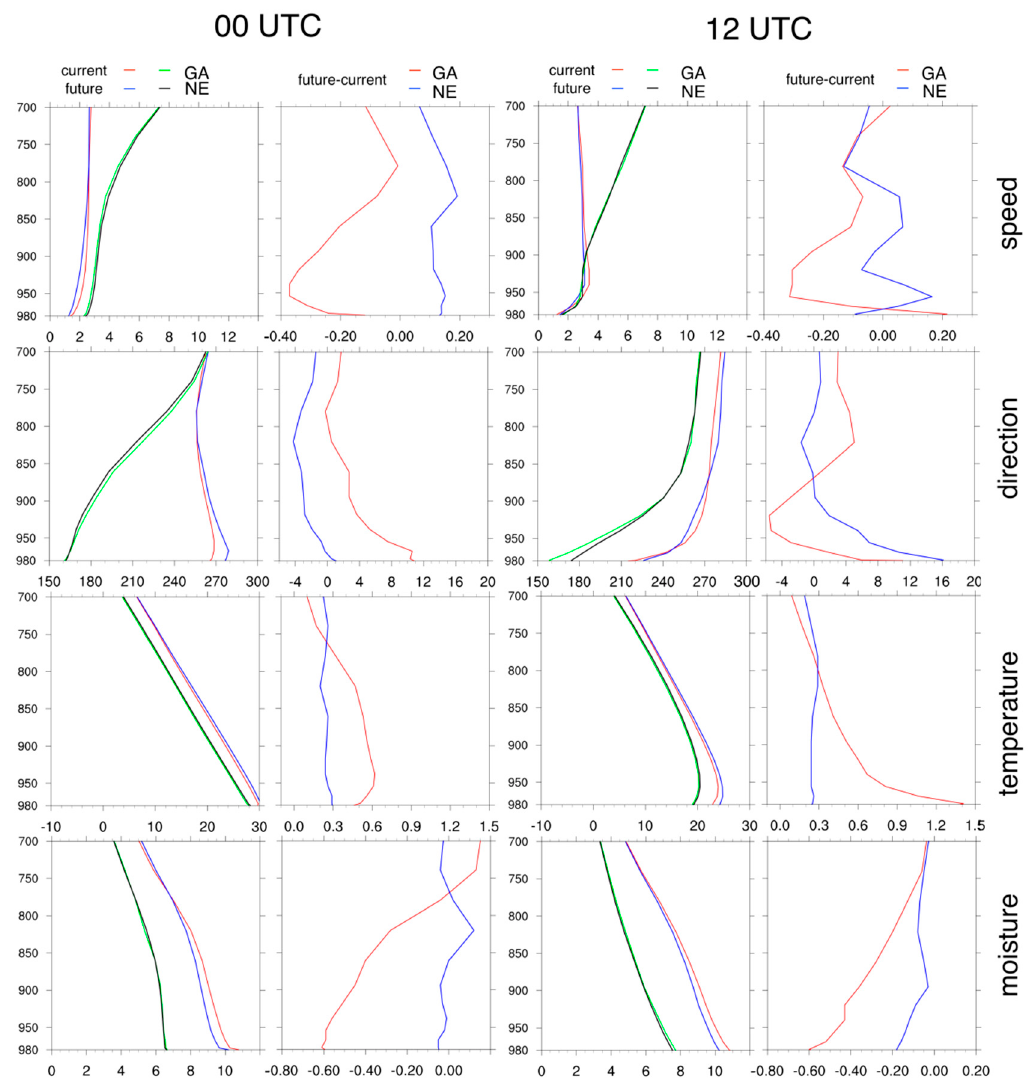
Figure 9. Vertical profiles of wind speed (m s − 1 ), wind direction, temperature ( ◦ C), and specific humidity (g kg − 1 ) at 00UTC (day) and 12UTC (night), averaged over the month of June under the current and future LULC conditions and their differences, at a location in Georgia and in Nebraska.